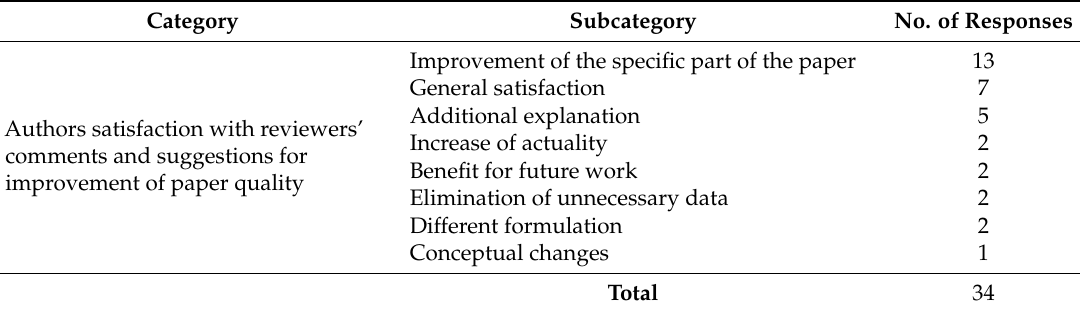
Table 8. Subcategories of authors’ satisfaction with reviewers’